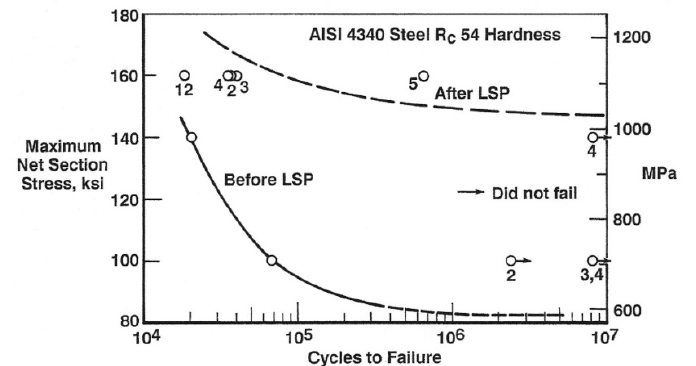
Figure 15. First fatigue life tests on laser shocked steel, 4340 steel at 54 Rc hardness, R = 0.1 [29].